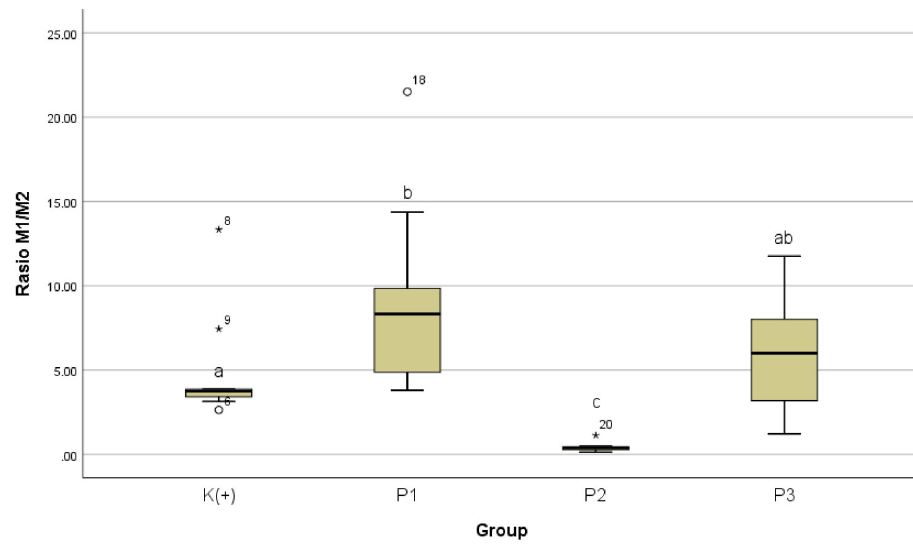
Figure 9. Graph of the median value of the M1/ M2 ratio after giving black cumin